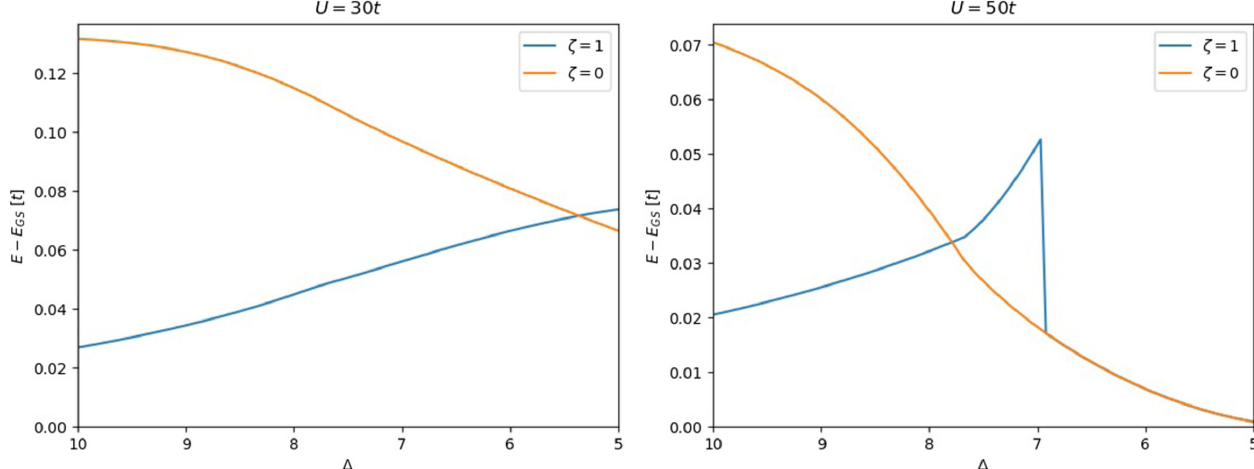
FIG. 6. Plots of the energy of the self-consistent Hartree-Fock solutions with ζ ¼ 0 ; þ 1 , compared to the ground-state energy E which has ζ ¼ − 1